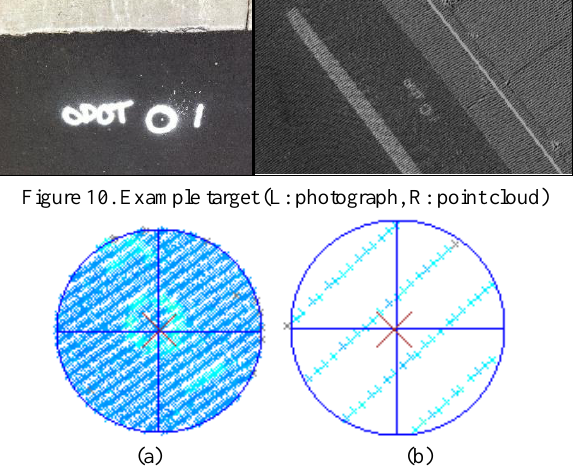
Figure 11. Sample target extraction for (a) dense and (b) sparse point cloud.